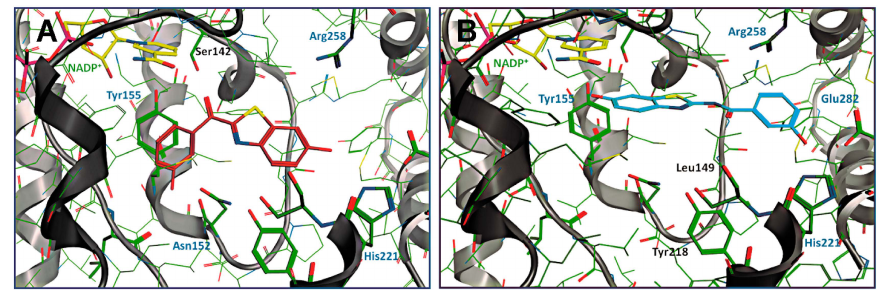
Figure 14. 17 β -HSD1 in complex with the two hits from Sparado et al. [134], (doi:10.1371/journal. pone.0029252.g010, doi:10.1371/journal.pone.0029252.g011) showing a 180 ˝ flipped orientation. IC 50 values of 44 nM ( A ) and 243 nM ( B